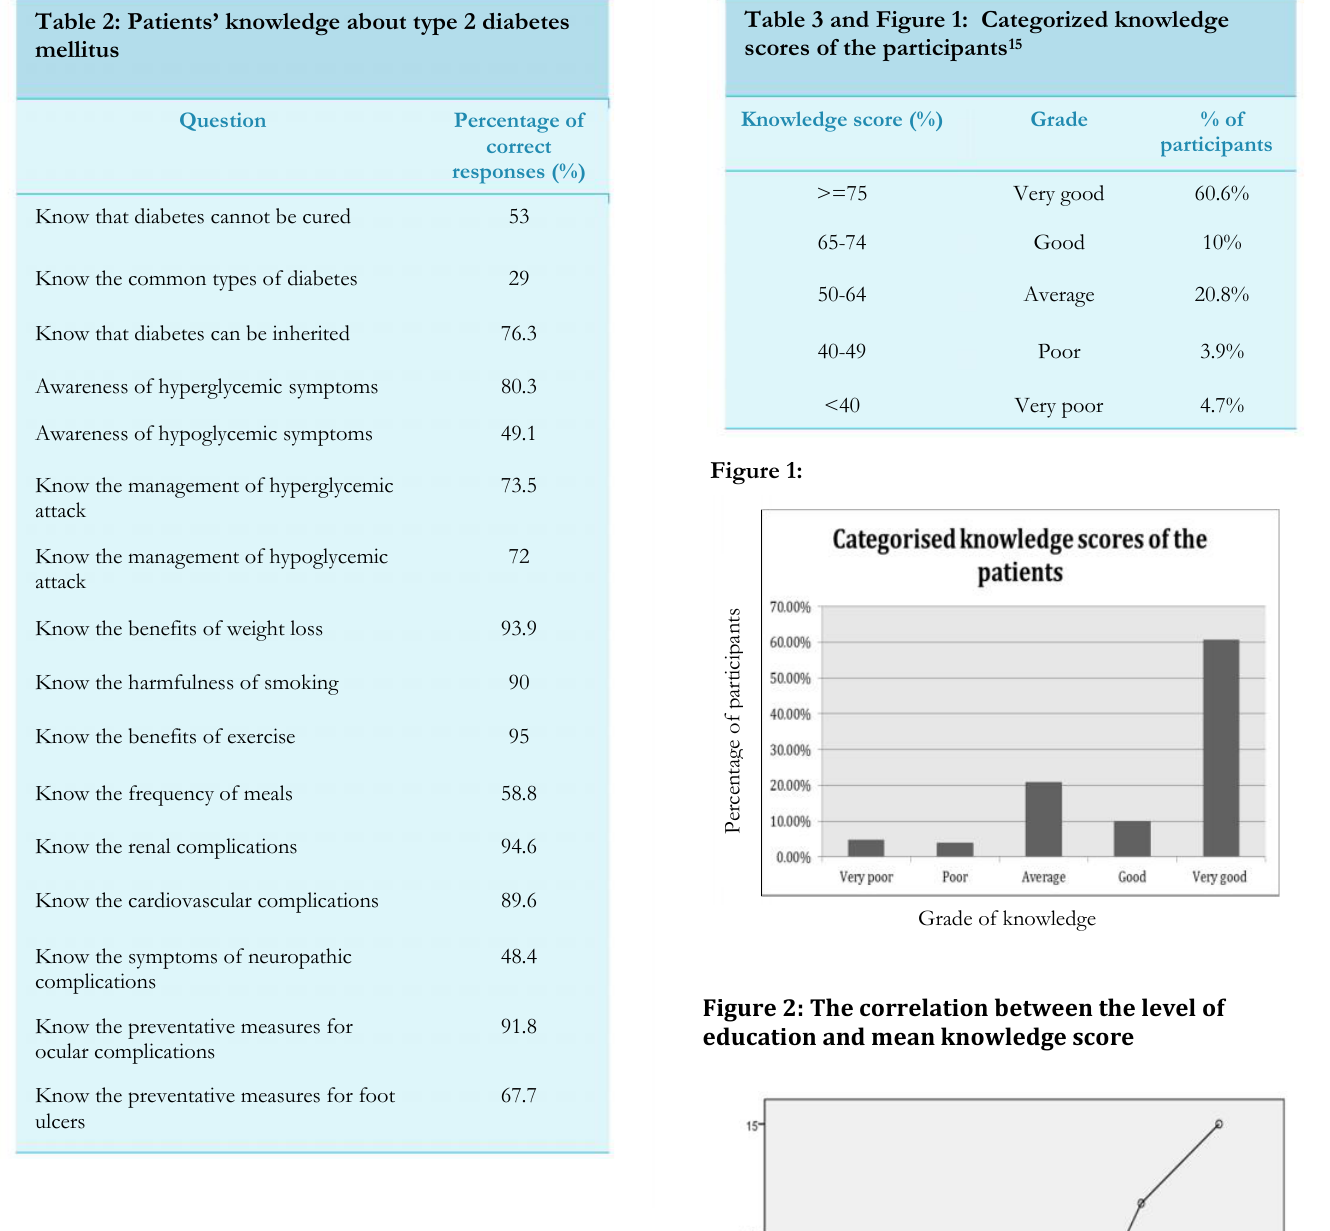
Table 3 and Figure 1: Categorized knowledge scores of the participants 15